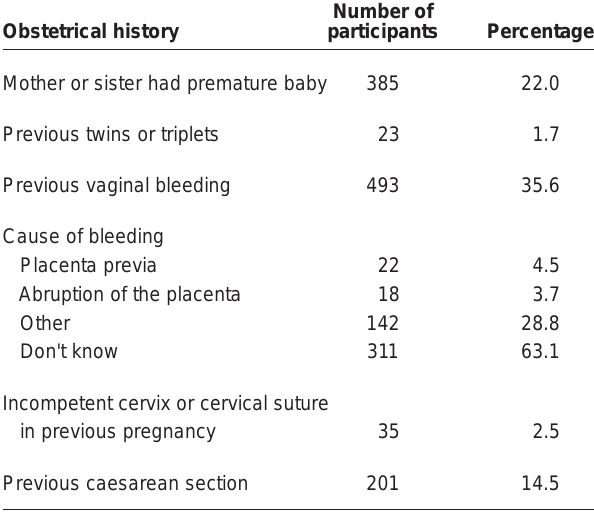
TABLE 7 Present obstetrical data of participants in the Edmonton Perinatal